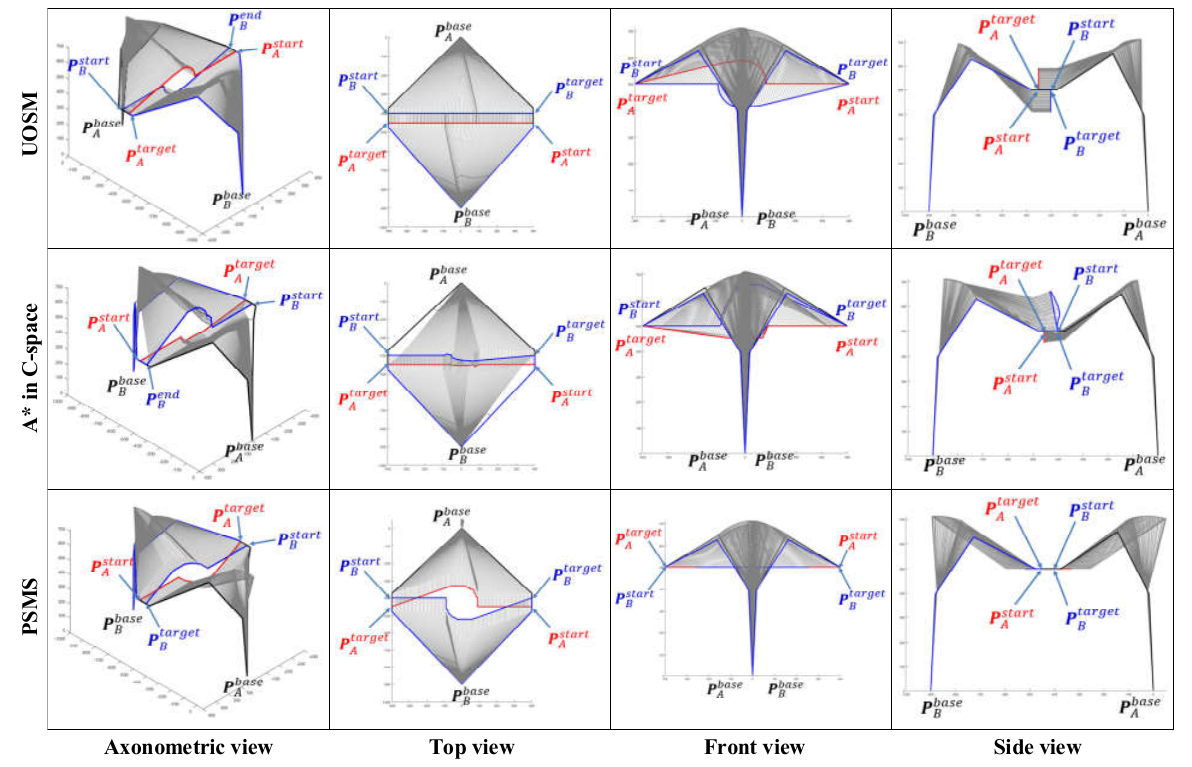
Figure 16. Comparison of simulation results of three path-planning algorithms for Case 3.